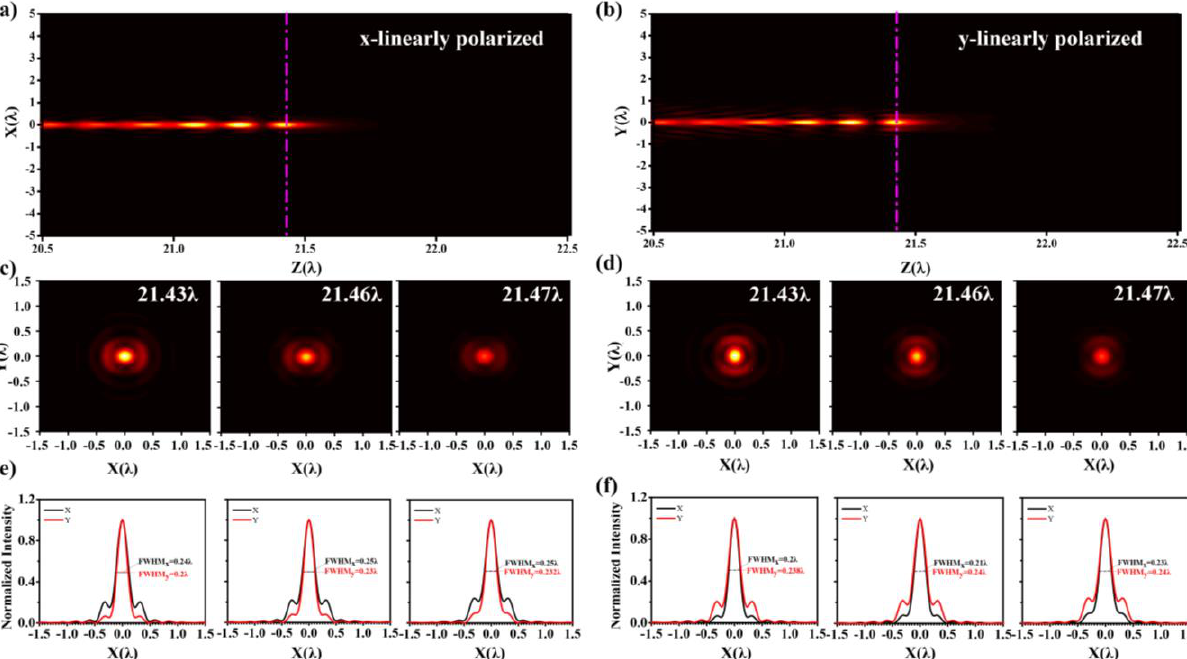
Figure 5. Intensity distribution of the light field in the XZ plane when illuminated by x–linearly polarized plane wave ( a ) and y–linearly polarized plane wave ( b ). ( c,d ) are the intensity distribution of the light field in the XY plane when illuminated with the x–linearly polarized plane wave and y–linearly polarized plane wave, respectively. ( e , f ) are the intensity distribution curves in the x and y directions corresponding to ( c , d ). Table 1. Parameters of the focal spot on the focal plane at different z for x– and y–polarized light. x Linearly Polarized Light y Linearly Polarized